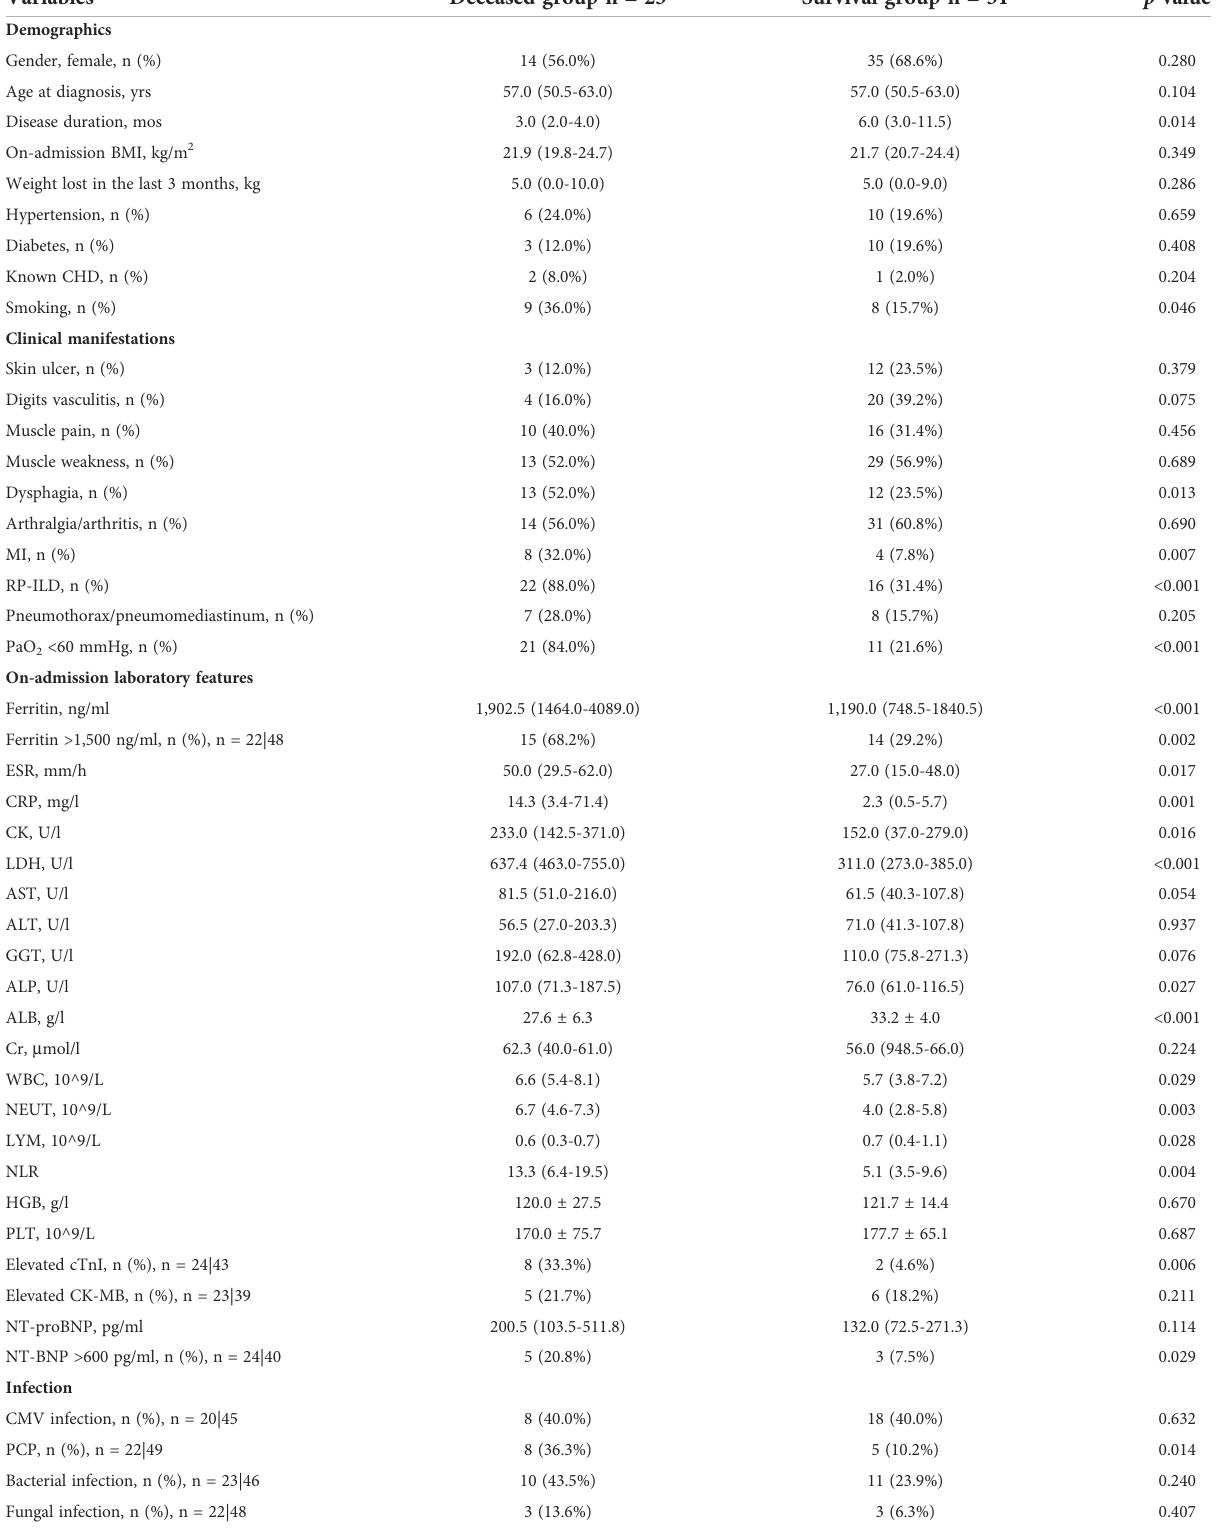
TABLE 5 Comparison of characteristics between deceased group and survival